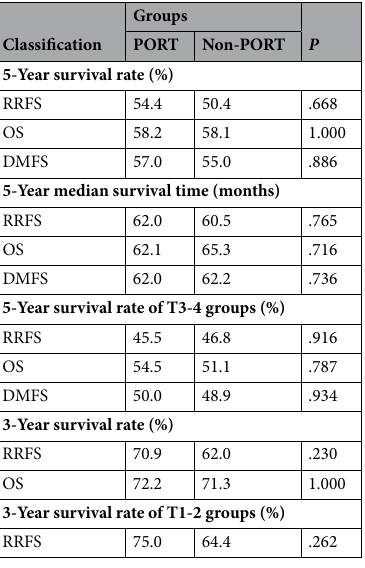
Table 2. Survival comparison. RRFS regional recurrence-free survival, OS overall survival, DMFS distant metastasis-free